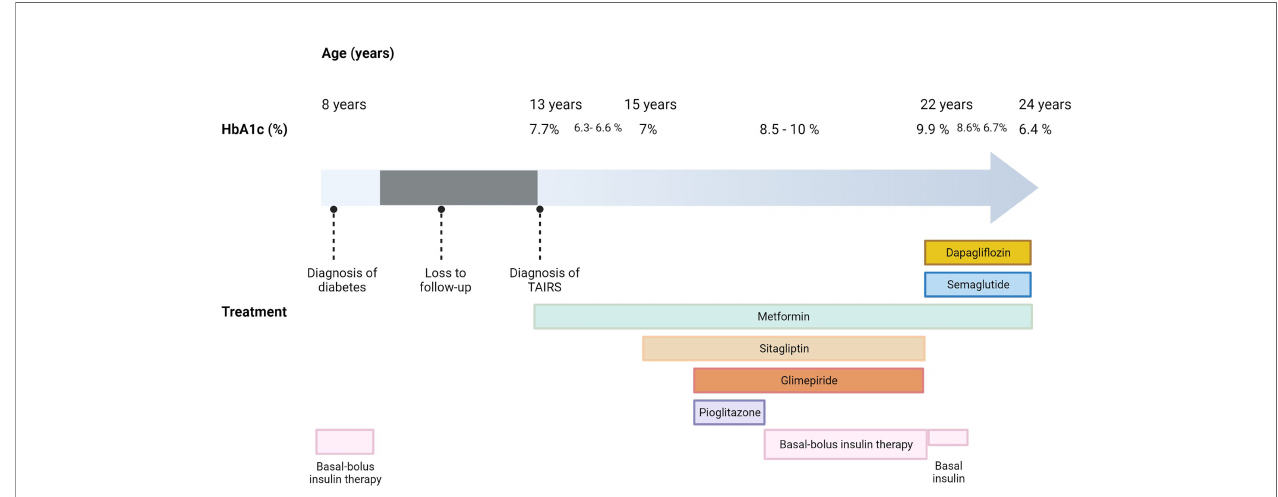
FIGURE 1 | Clinical course of glycemic control and treatment timeline in the reported case of type A insulin resistance syndrome. HbA1c, glycosylated hemoglobin; TAIRS, type A insulin resistance